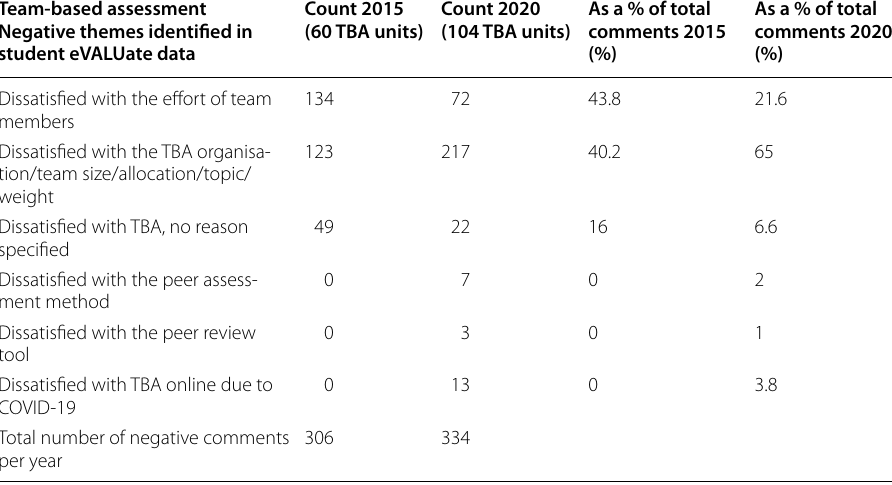
Table 7 The comparison of negative themes coded from the voluntary student feedback in 2015 and 2020 and their associated percentage frequencies Team‑based assessment Negative themes identified